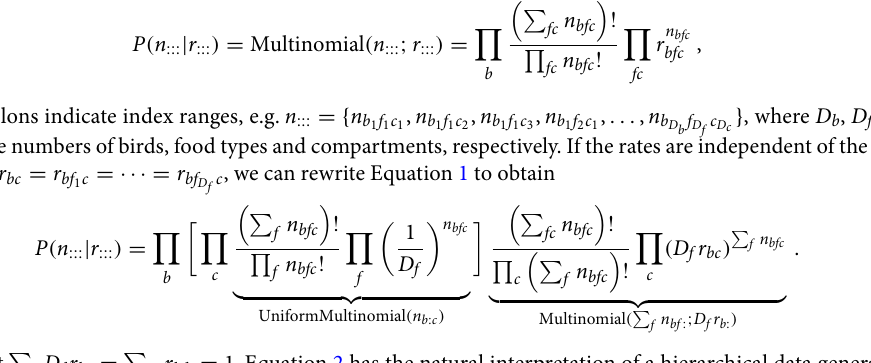
models for the Bayesian model comparison such that—together with the 7 models mentioned previously—we tested 13 models in total. More explicitly, we assume the probability of observing the actual counts n bfc are given by